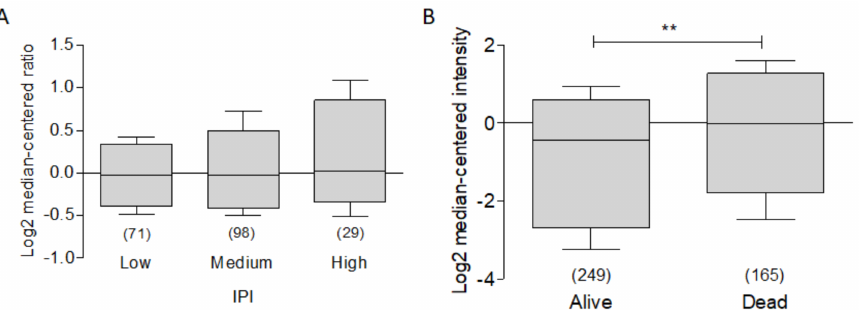
Figure 11. BCL-xL as a potential biomarker in Lymphoma. ONCOMINE BCL-xL expression was revised in Rosendwald et al. [86] for lymphoma. ( A ) There is a relative higher expression of BCL-xL and IPI value. ( B ) The dataset analysis of Lenz et al. [87] shows a non-significantly higher expression of BCL-xL in dead vs. alive patients.